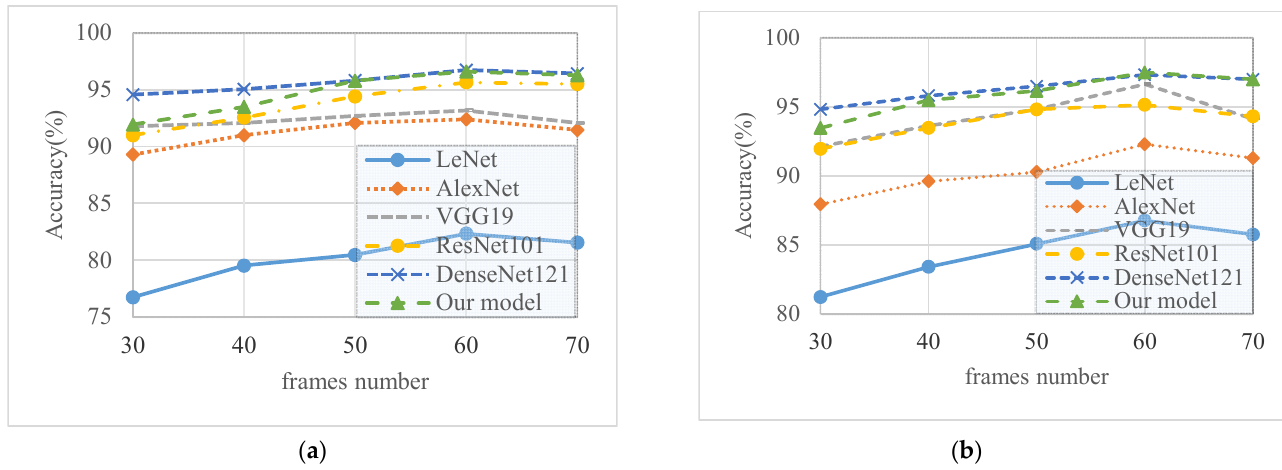
Figure 4. The recognition accuracy of multiply CNN model training on images generated by data augmentation with different frame numbers on the Florence-3D dataset ( a ) and UTkinect-3D dataset ( b ). Table 1. Comparison of space complexity and time complexity of CNN models.